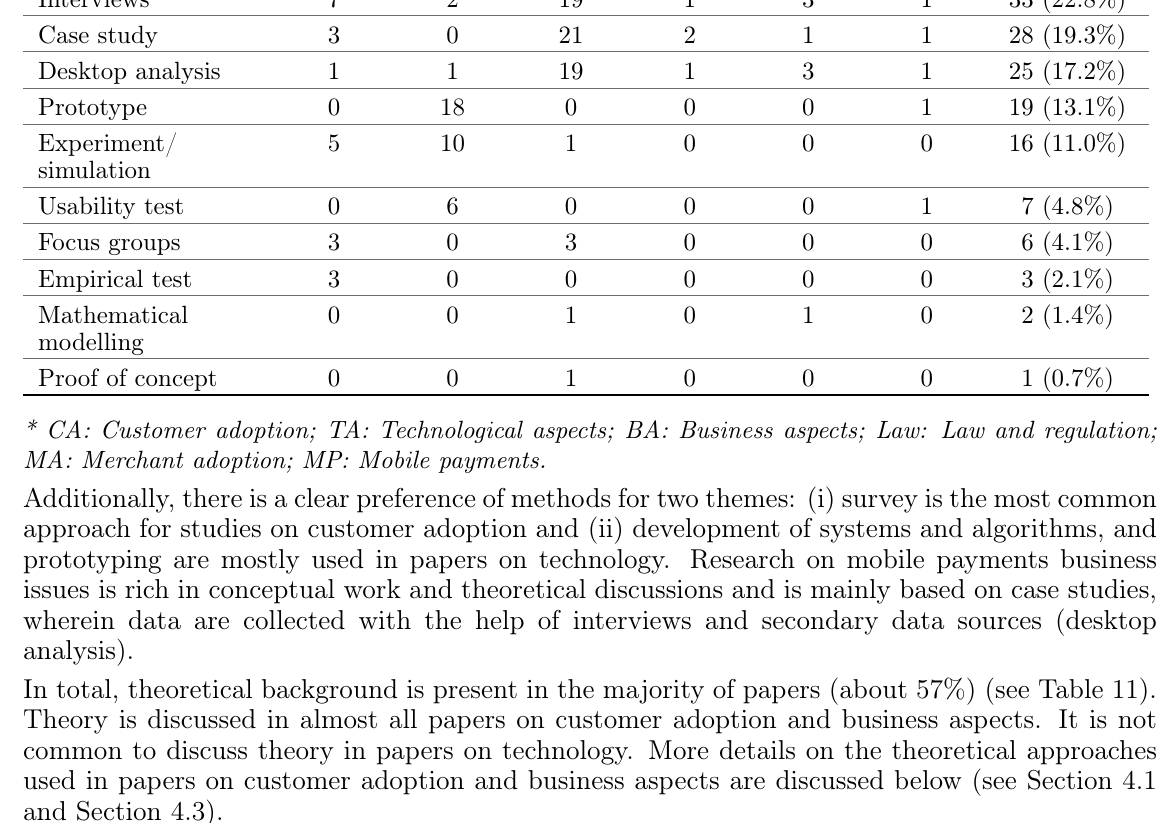
Table 11. Theoretical base in research on mobile